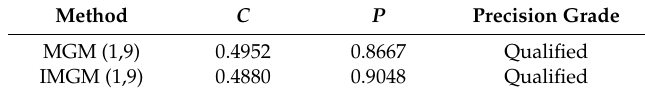
Table 5. The precision grade of the Multivariate Grey Model (MGM (1,9)) and IMGM (1,9) for vibration